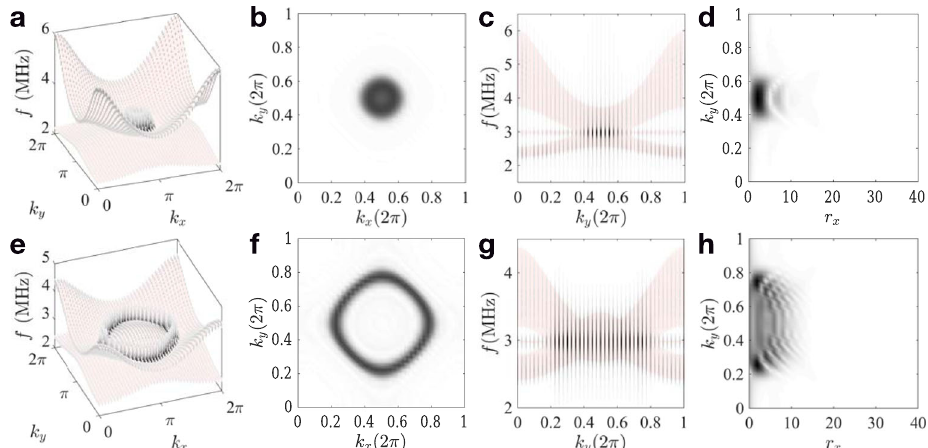
= 210 pF, C = 260 pF, C = C = C = 50 pF. a , e A B m t γ ffiffiffiffiffiffiffiffiffiffiffiffiffiffiffiffiffiffiffiffiffiffiffiffiffiffiffiffiffiffiffiffiffiffiffi p ð C b þ C m þ 4 C t Þ L